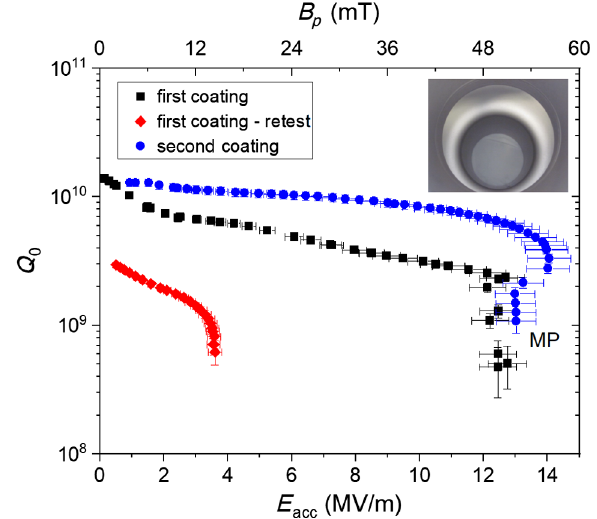
FIG. 10. Results from the rf tests in LHe at 4.3 K of the 952.6 MHz prototype single-cell cavity after coating the inner surface with Nb 3 Sn. The inset shows a picture of the inner surface after forming the Nb 3 Sn